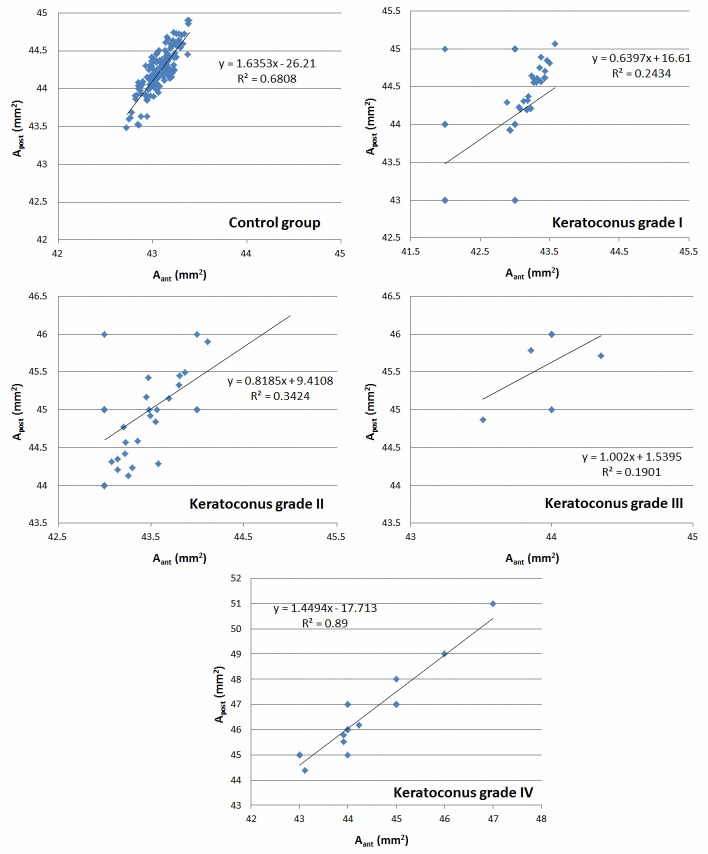
Scatterplots showing the relationship between the areas of the anterior corneal surface (Aant) and posterior corneal surface area (Apost).The adjusting line to the data obtained by means of the least-squares fit is shown.